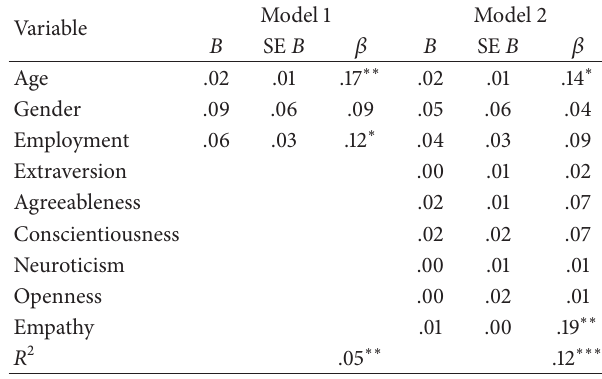
Table 5: Hierarchical multiple regression: association between demographics, personality traits, empathy, and willingness to